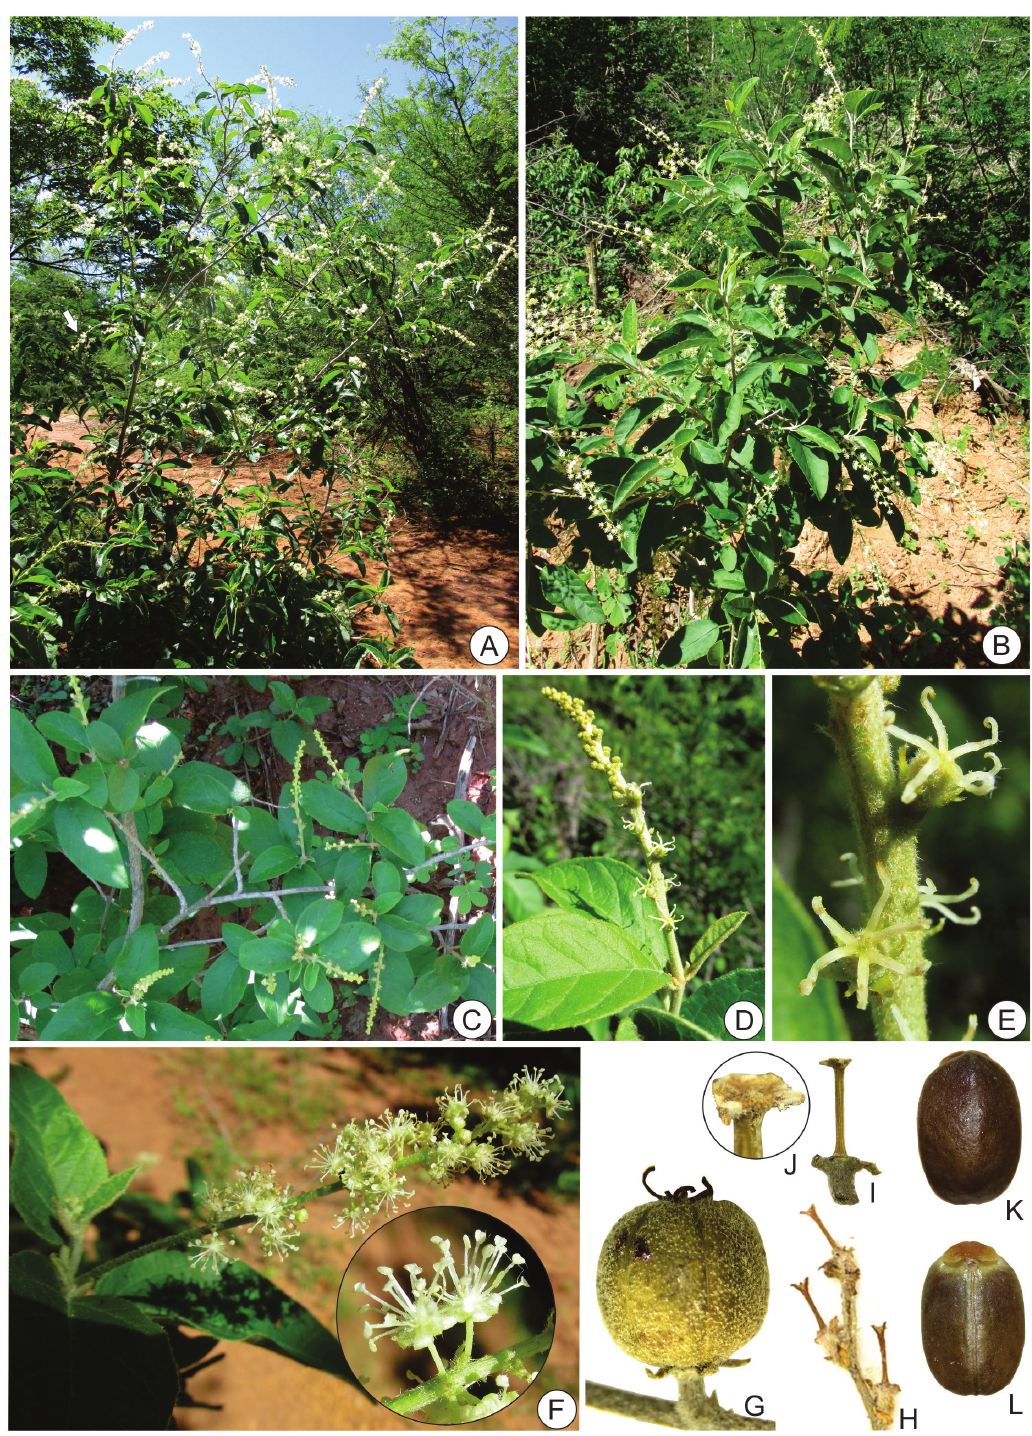
Fig. 2. Croton sertanejus Sodré & M.J.Silva sp. nov. A–B . Habit. C . Flowering branch showing ramifying in alternate branches. D . Inflorescence showing pistillate flowers and staminate buds. E . Pistillate flowers. F . Unisexual staminate inflorescence. G . Fruit. H–I . Fruit columella. J . Apex of columella with irregular and plane tips. K . Seed, dorsal side. L . Seed, ventral surface. A–F = Population from Oliveira dos Brejinhos, Bahia ( R.C. Sodré et al. 3350 , holotype; BOTU); G–L = K.N.C. Castro & J.B.A. Souza 471 (CEN). Photographs: R.C.